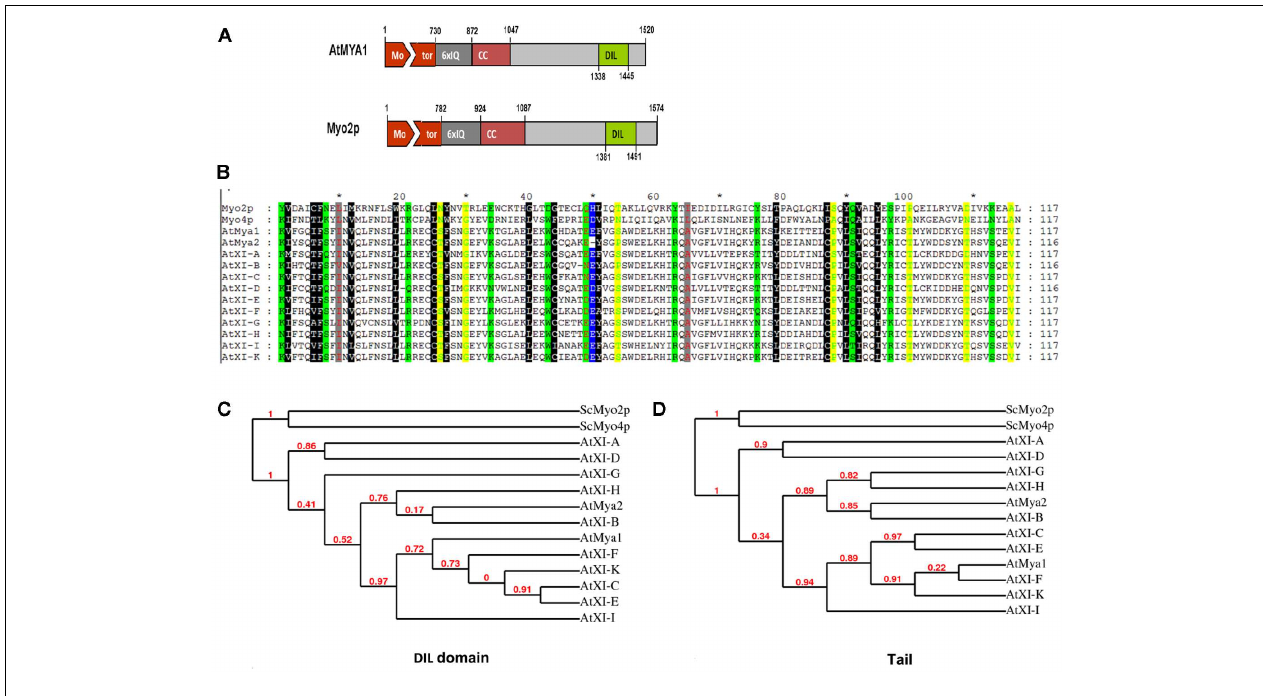
highly conserved amino acids between Arabidopsis class XI myosins and the yeast myosinV are shown in color. (C,D) Cladogram tree for the DIL and tail domain of yeast classV myosins, ScMyo2p, ScMyo4p, and class XI myosins from A. thaliana is illustrated. Branch support values are presented in